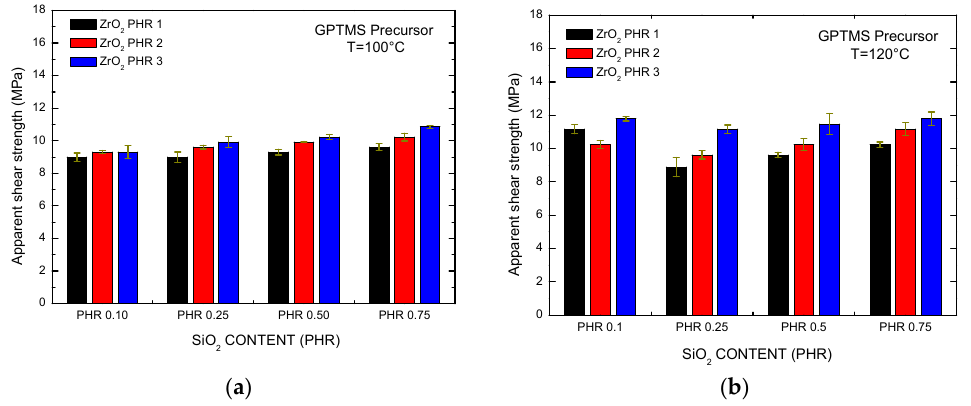
Figure 14. Apparent shear strength of epoxy-SiO 2 -ZrO 2 adhesives using the GPTMS precursor at different temperatures: ( a ) T = 100 °C; ( b ) T = 120 °C. different temperatures: ( a ) T = 100 ◦ C; ( b ) T = 120 ◦